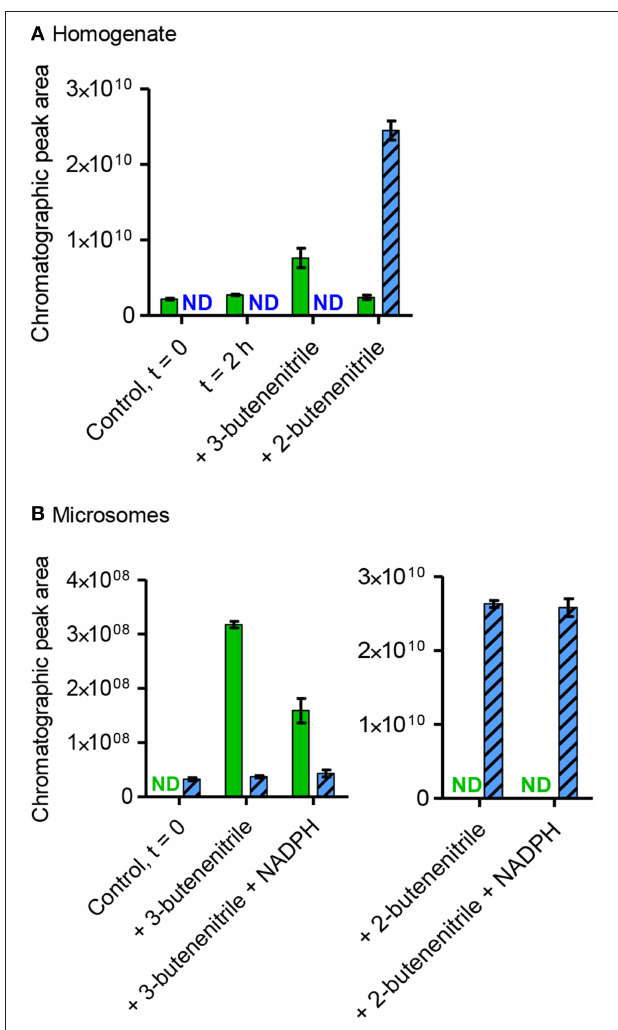
FIGURE 5 | Presence, production and consumption of 3-butenenitrile (19) and 2-butenenitrile (20) following incubation with homogenate or microsomes from A. petiolata . Homogenate (A) or microsomes (B) were incubated with or without addition of exogenous 3-butenenitrile or 2-butenenitrile (mixture of ( Z )- and ( E )-isomers), homogenate for 2h and microsomes for 30min. The content of 3-butenenitrile (green bars, m / z 67, 4.2min) and 2-butenenitrile (blue striped bars, m / z 67, sum of isomers: 3. 8 + 4 .5min) at the end of the incubation period was determined as the EIC peak area as obtained by SPME-GC-MS. The mean ± range of two technical replicates is depicted. For homogenate the incubated unspiked control is shown to evaluate whether endogenous sinigrin in this fraction led to an increase in the amounts of 3- or 2-butenenitrile. ND, not detected; t = 0 , time point